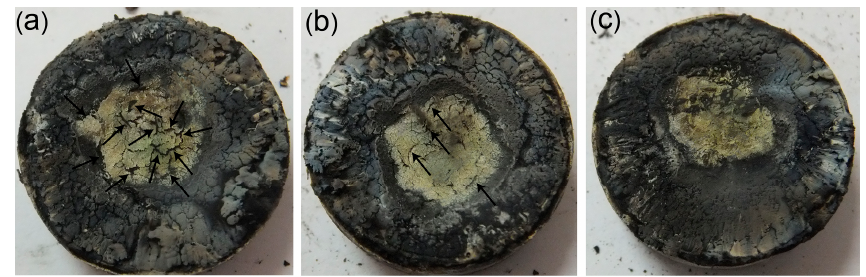
Figure 7. Photographs of ablated SR composites: ( a ) SR00; ( b ) SR10 and ( c ) SR16.